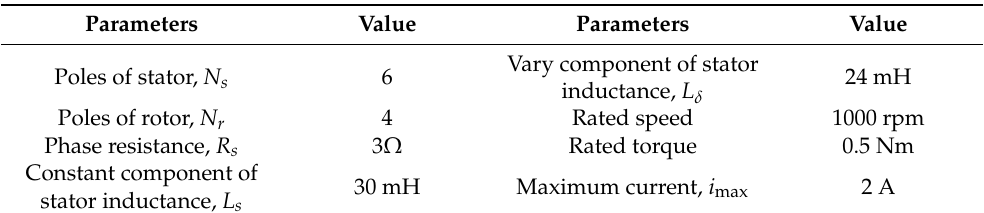
Table 3. Parameters of VFRM.